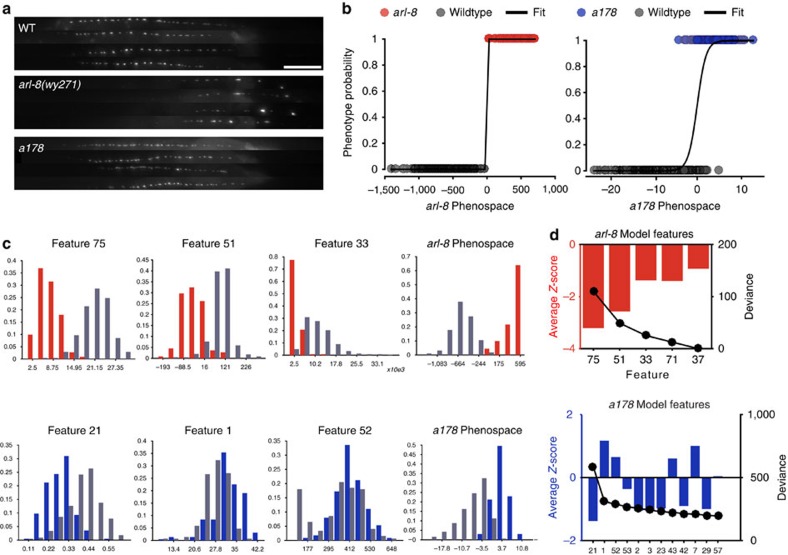
Phenotypic differences between populations are revealed by logistic regression models.(a) Images of wild type, arl-8 (easily identifiable) and a178 (no obvious phenotype), four images per genotype; scale bar, 20 μm. (b) Plots showing logistic regression fits for obvious (left, arl-8) and subtle (right, a178) phenotypes. (c) Histograms for the three most relevant features, and the score in the arl-8 and a178 phenotypic scales. N=111 (arl-8(wy271)), 228 (a178). Features listed are: 75: number of puncta in the top 75% of size range; 55: 10th percentile of integrated intensity; 33: intensity of posterior puncta; 21: puncta intensity homogeneity; 1: number of puncta; 52: interpunctal intensity. (d) Relevant features obtained from stepwise logistic regression (from most to least relevant, left to right) for arl-8 and a178. Black line (quantification on the right axis) shows the change in model deviance as each feature is added during model construction. Full feature descriptions, statistical analysis for model creation and feature selection are listed in Supplementary Information.